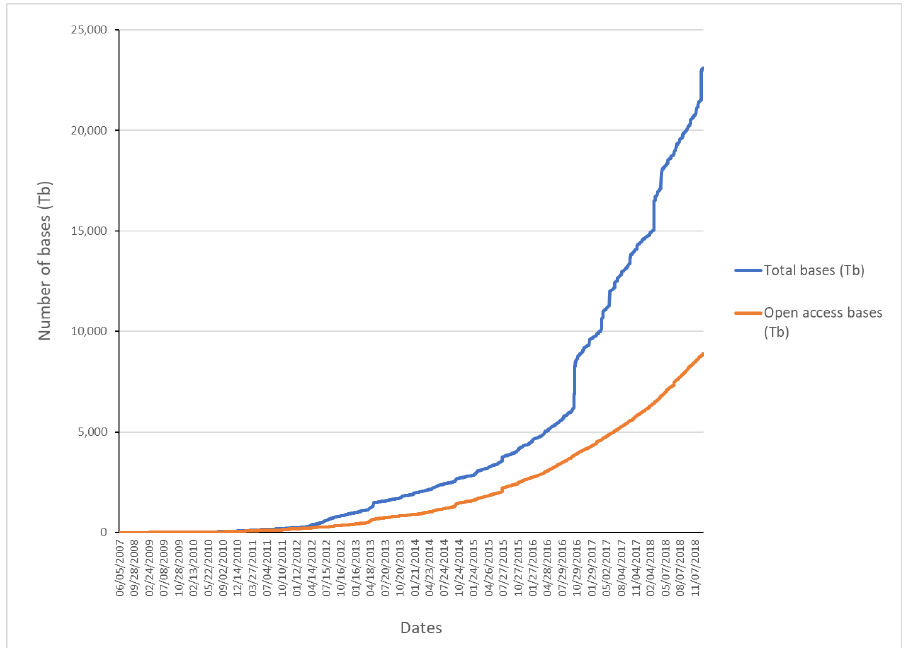
Figure 7. Evolution of the SRA, which stores raw data from massive sequencing projects. The total number of bases in Terabytes (Tb) in blue color and of exclusively public access in red color.